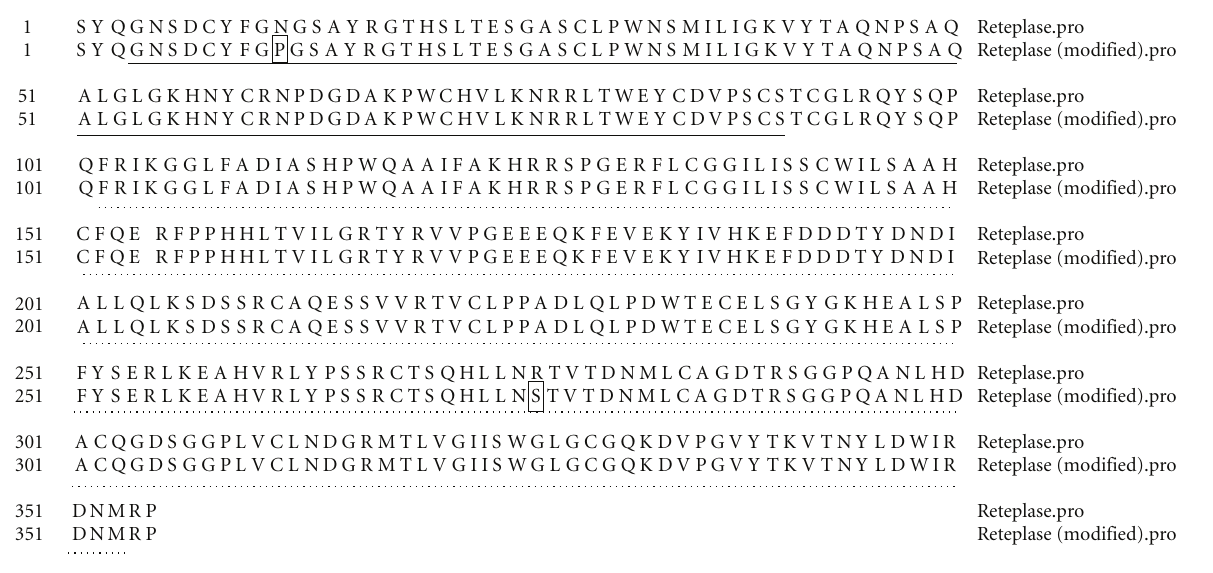
Figure 3: Amino acid sequence comparisons between native and rPA SDM mutants. Bold line indicates kringle 2 domain while dotted line indicates the serine protease domain. The asaparagine substitutions have been boxed. Reteplase refers to WT rPA gene while modified reteplase refers to mutated rPA